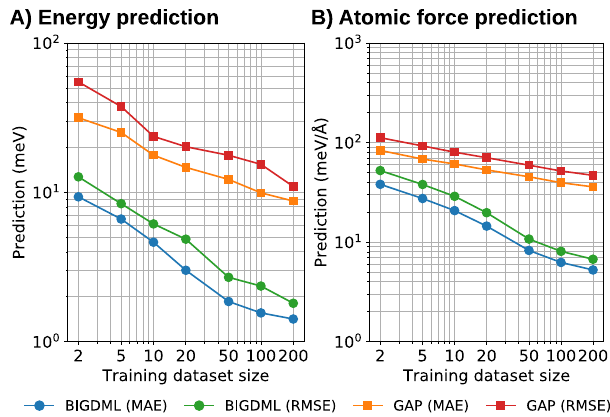
Fig. 3 BIGDML and GAP performance comparison for graphene. Comparison of the ( A ) energy and ( B ) forces learning curves, both trained using the same datasets.